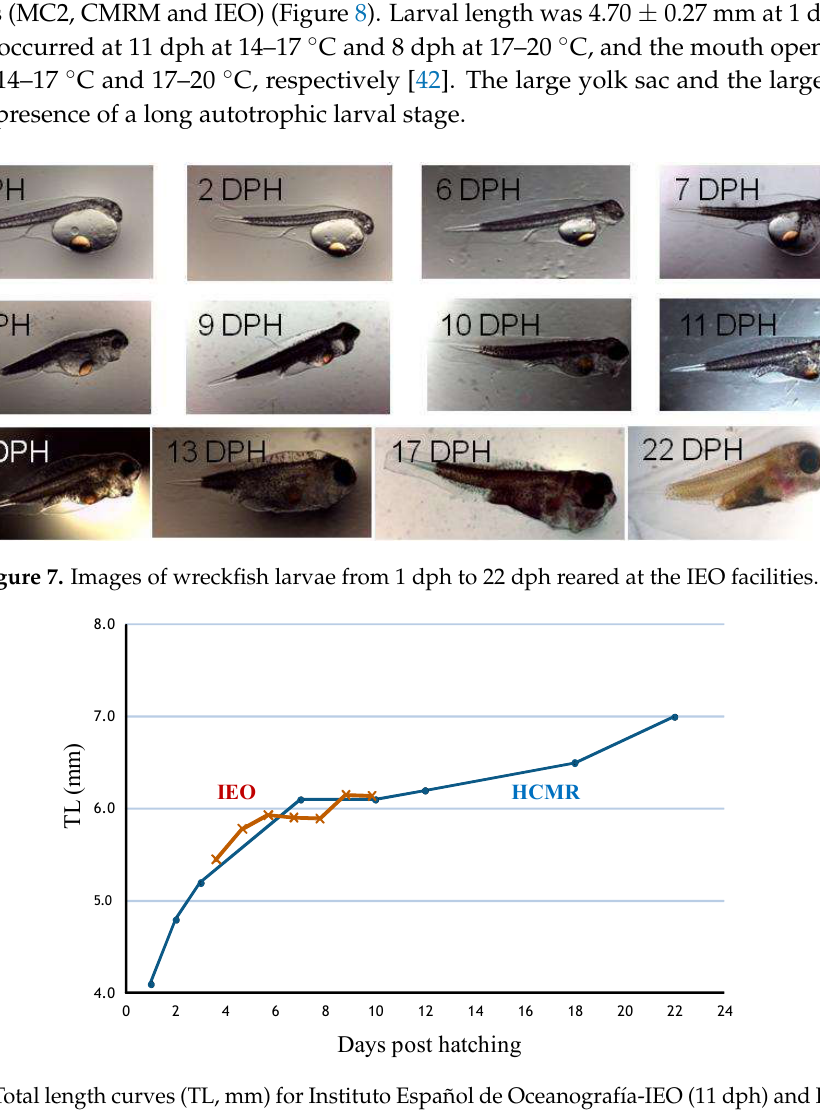
Figure 9. Mean growth (dry weight, squares) and length during temperature trials. The highest temperature is represented with the red color while the coldest one with the blue. The bars indicate standard deviation of the values. The average length increased from 4.56±0.08 mm (0 dph) to 6.02±0.27 mm (26 dph). This development occurred mainly during the first 10 days of life, staying relatively constant afterwards. Growth showed a different pattern with an irregular distribution with the larvae age. Newly hatched larvae weighed 0.34±0.07 mg (dry weight) and maximum values of 0.47 mg were registered at 10 dph and 26 dph. Some malformed individuals were observed in the rearing trials (Figure 10). The problem was identified as similar to a syndrome related to swollen yolk sac (SYSS) described in Murray cod (freshwater fish in Australia), that it is related to inadequate nutrition of the broodstock [43]. Furthermore, similar appearance has been also described in the Blue Sac Disease that is common in trout [44]. Toxicity from nitrogen compounds such as ammonia or oxidative stress have been suggested to play an important role in the appearance of this type of deformity. A situation of SYSS could be happening in wreckfish larvae but further studies are required to confirm this conclusion.